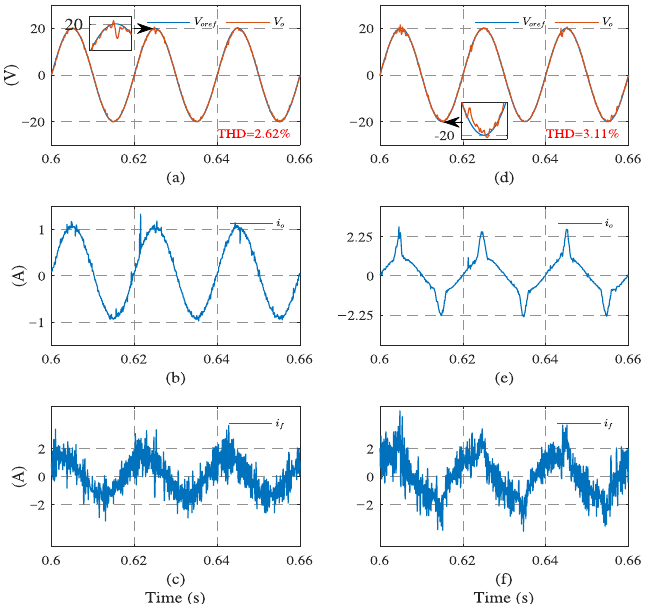
Figure 9. System experimental results with load current sensor. Under linear load: ( a ) output voltage, ( b ) load current, and ( c ) filter current. Under nonlinear load: ( d ) output voltage, ( e ) load current, and ( f ) filter current.